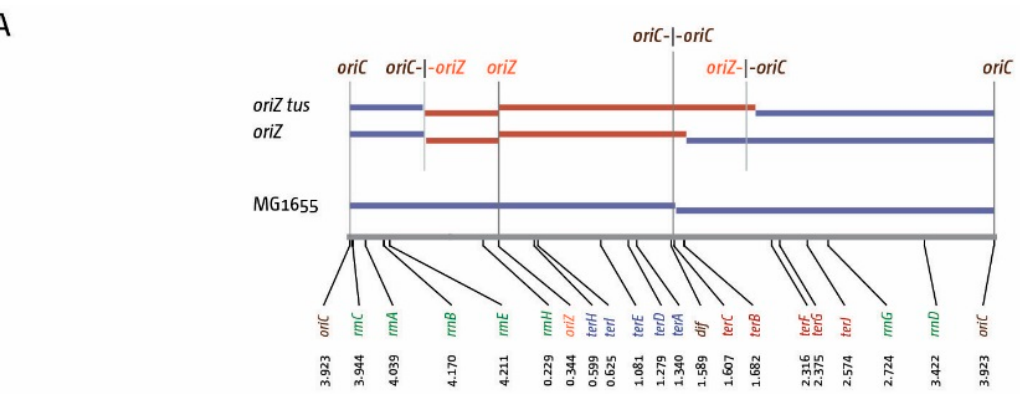
Figure 3. Cont. Figure 3.